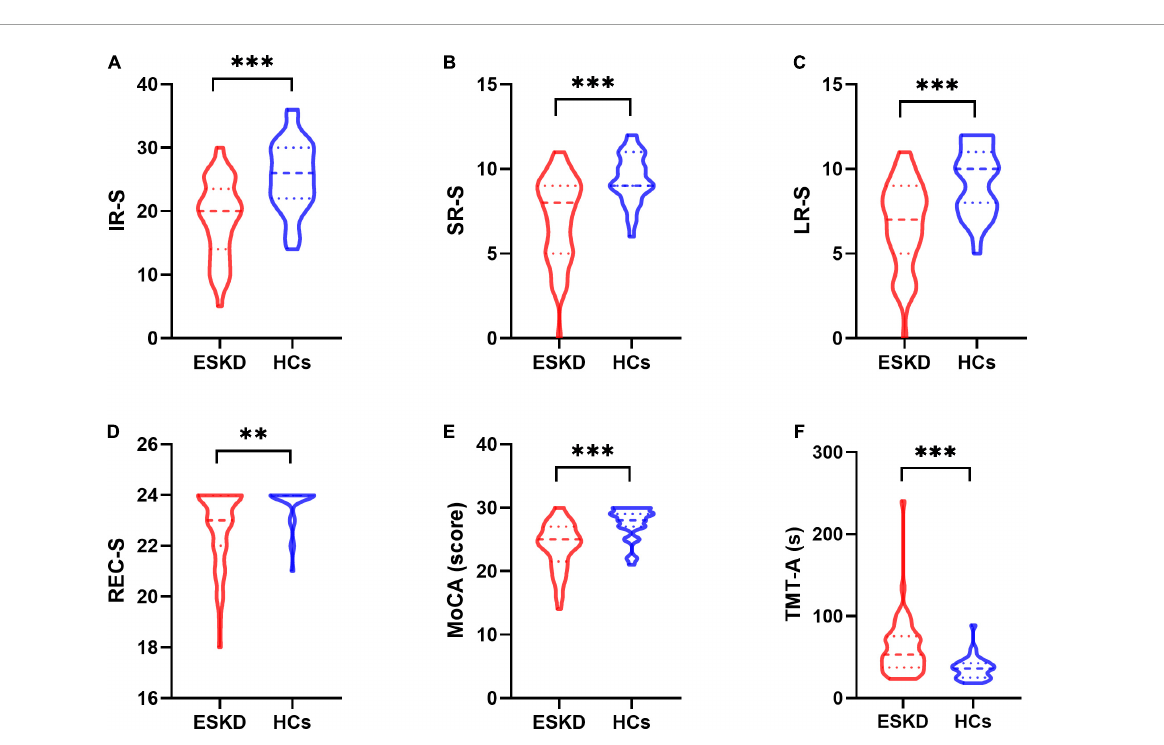
FIGURE1 The violin plot depicts group differences in neurocognitive tests between patients with ESKD and HCs after adjusting for age, sex, and education level. (A) The ESKD group had lower IR-S than HCs ( p < 0.001). (B) The ESKD group had lower SR-S than HCs ( p < 0.001). (C) The ESKD group had lower LR-S than HCs ( p < 0.001). (D) The ESKD group had lower REC-S than HCs ( p = 0.006). (E) The ESKD group had a lower MoCA score than HCs ( p < 0.001). (F) The ESKD group had longer TMT-A than HCs ( p < 0.001). ESKD, end-stage kidney disease; HCs, healthy controls;